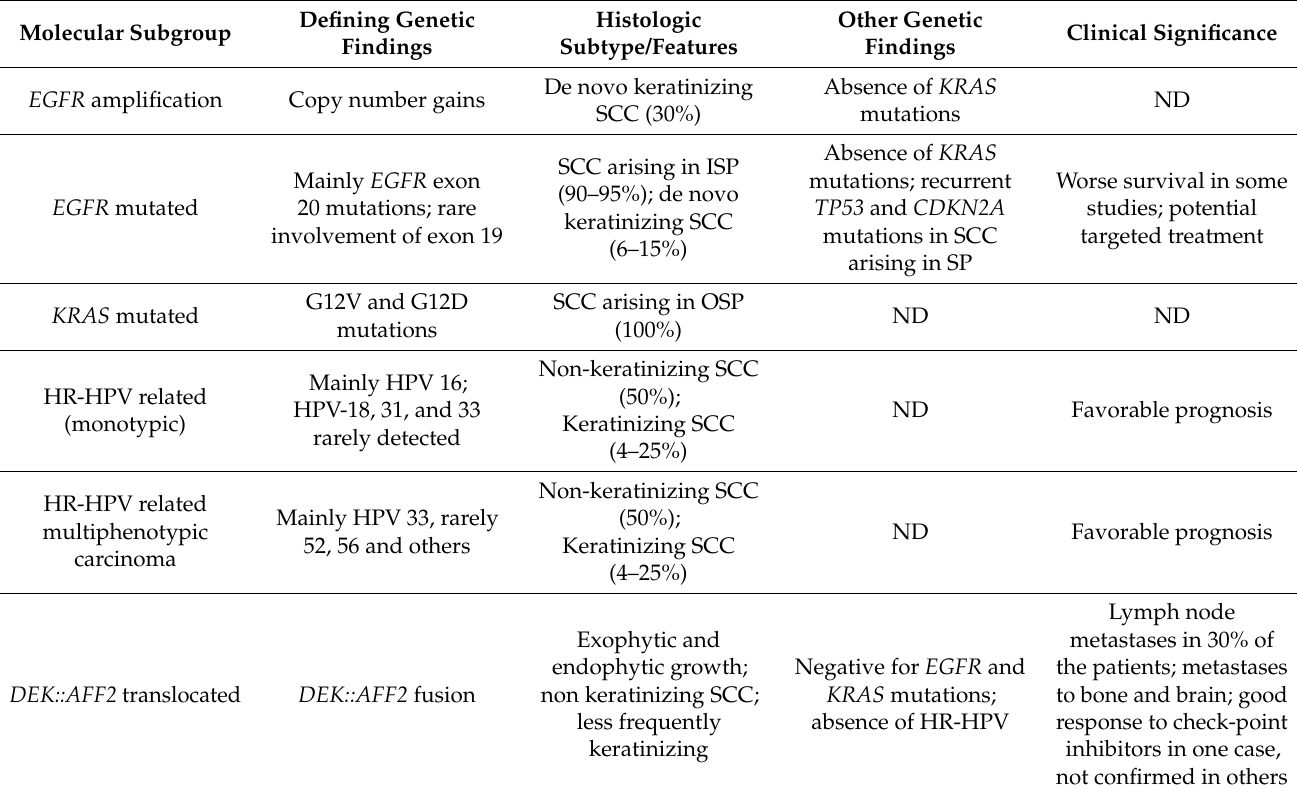
Table 1. Molecular subgroups of sinonasal squamous cell